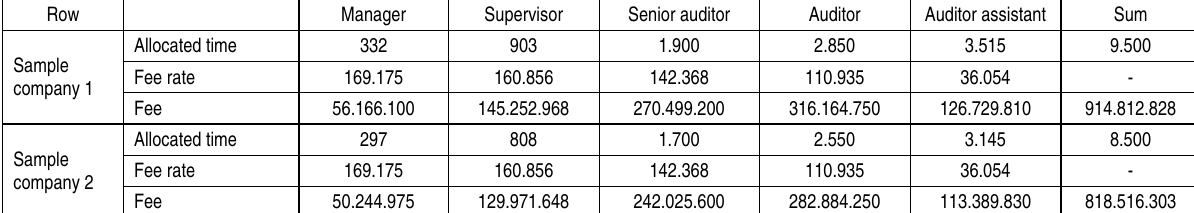
Table 12 presents the audit team employees fee calculation for 10 samples companies. Table 12. How to calculate the auditing team employees in 10 sample